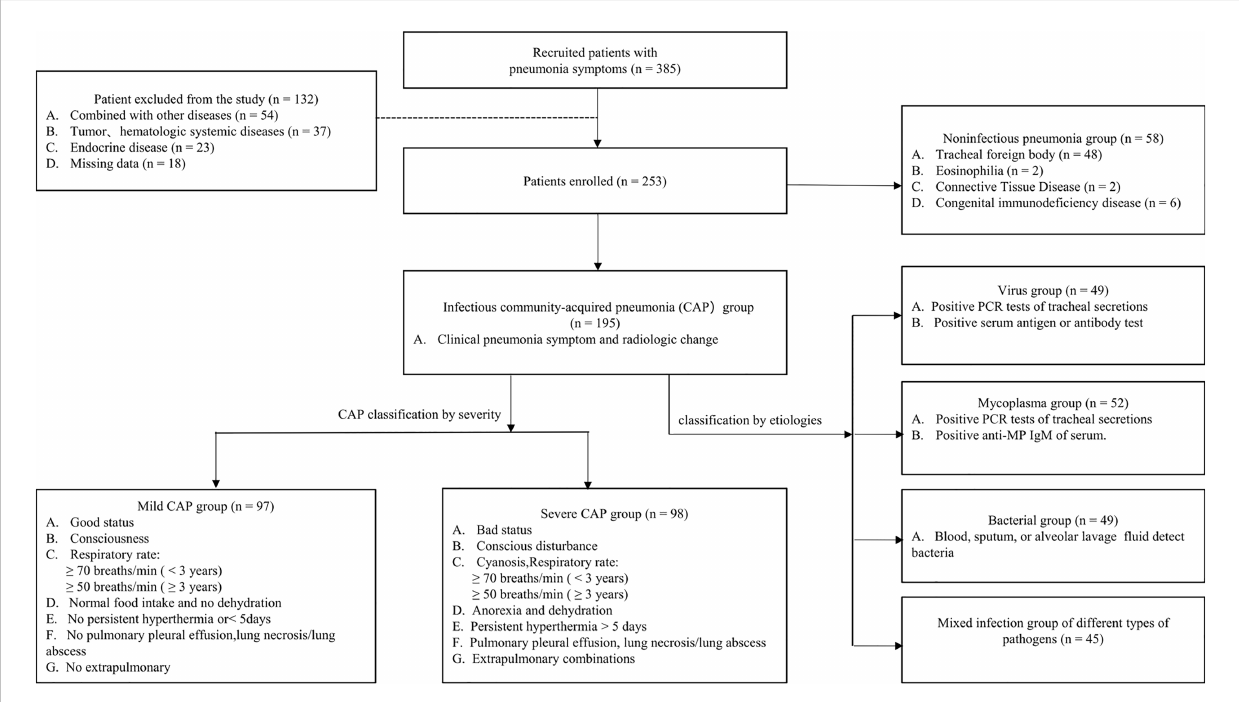
FIGURE 1 Flow diagram of recruitment and follow-up research in this cohort